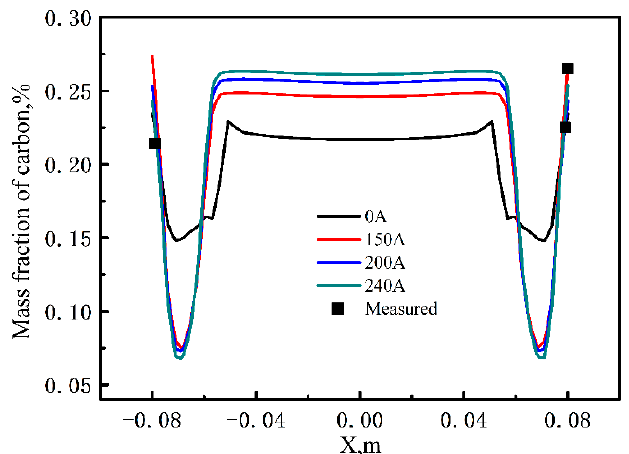
Figure 11. Mass fraction of carbon along the X direction 1.4 m below the meniscus.